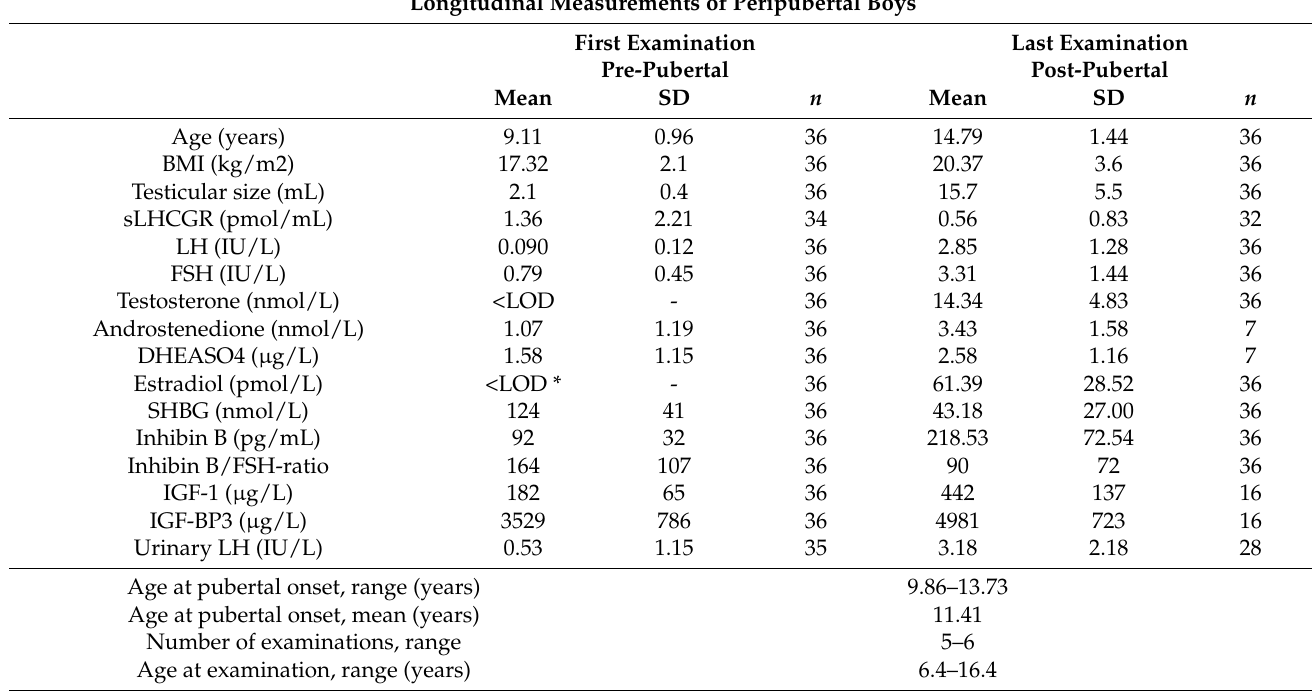
Table 2. Baseline characteristics of 36 healthy boys followed longitudinally. LOD = limit of detection. * all but two measurements were below LOD.